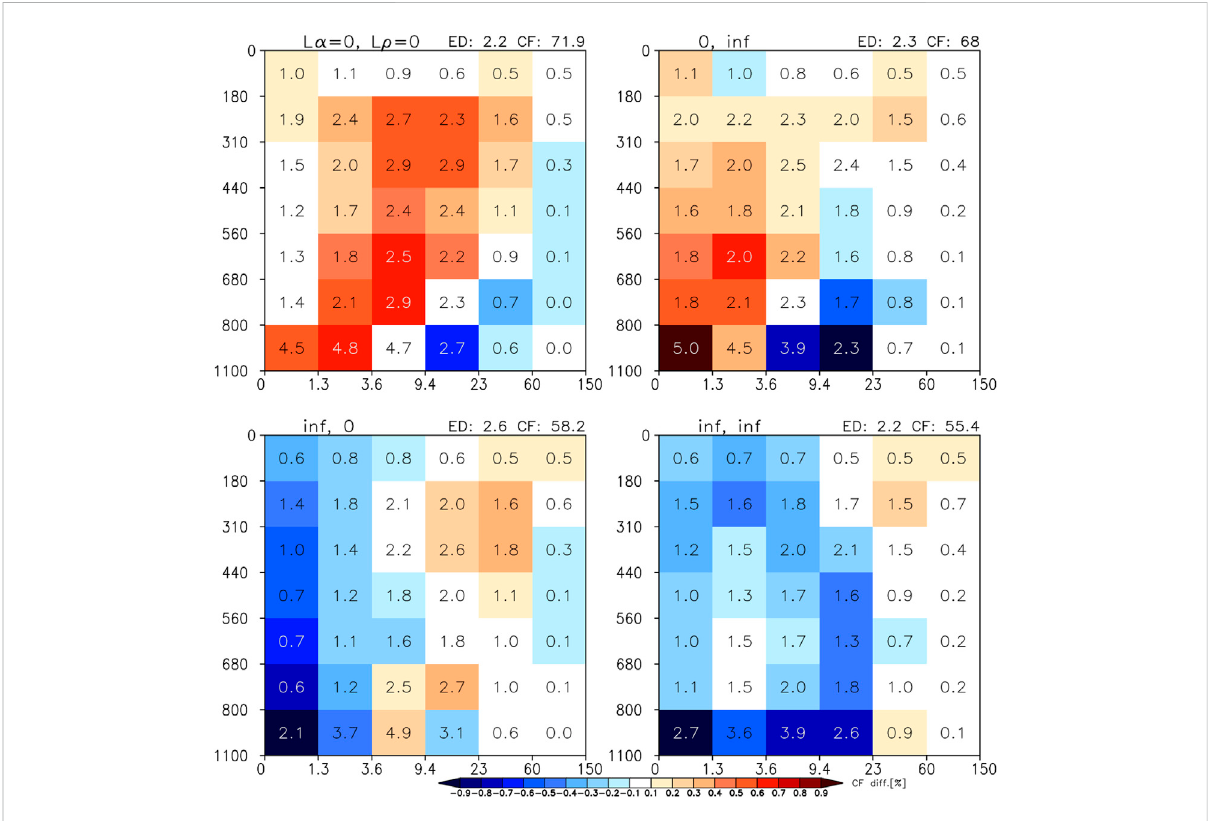
FIGURE 13 Mean CF errors discretized in CTP-TAU bins (i.e., joint histogram errors) for four combinations of extreme L α and L ρ . Zero values correspond to random vertical overlap of cloud fraction and COD ranks, while in fi nite values correspond to maximum cloud fraction overlap and perfect correlations of COD